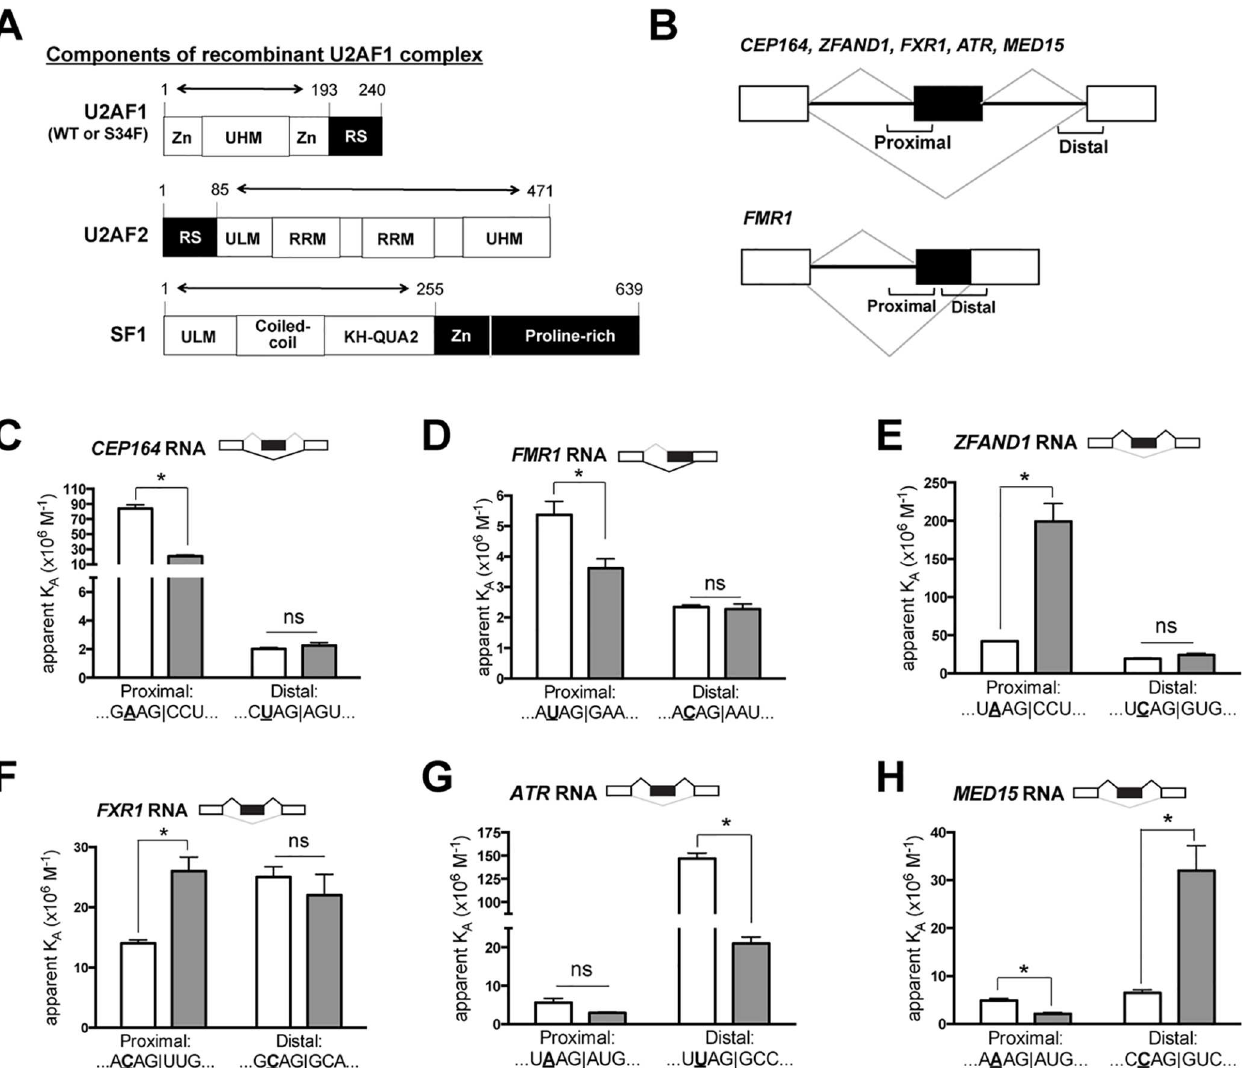
Fig 5. Differential binding of mutant and wild-type U2AF1 complexes to RNA oligonucleotides explains most S34F-associated alterations in RNA splicing. (A) . Cartoons illustrate components of recombinant U2AF1 complexes used in the bindingassay. Full-length proteins are shown but only partial sequences(denoted by bi-directional arrows) were used to make recombinant protein complexes. KH-QUA2, K-Homology Quaking motif; RRM, RNA recognition motif domain; RS, arginine/serine-rich domain; UHM, U2AF homology motif; ULM, U2AF ligand motif; ZnF, zinc finger domain. (B) . Scheme of alternativesplicing patterns for cassette exons (top diagram) and 5’ extended exons from competing 3 0 splice site selection(bottom). The brackets indicate the positionsof RNA oligonucleotides used for the bindingassays. Exons are shown as boxes: white boxes indicate invariant exonic sequences and black boxes denote sequencesthat are incorporated into mRNA (exonic) only when the proximal 3 0 splice sites are used. Introns are shown as solid lines. The grey lines represent possiblesplices. The names of characterized genes that conform to the patterns shown in the upper and lower cartoons are indicated. (C—H) . Mutant and wild-type U2AF1 complexes have different affinities (K A ’s) for relevant 3 0 splice site oligonucleotides. To accomplish the bindingassays, the wild-type or mutant U2AF1 protein complexes were titrated into 5’ fluorescein-tagged RNA oligonucleotides over a range of concentrations as describedin the Supplemental Materials and Methods. RNA sequencesfrom -4 to +3 relative to the 3 0 splice sites (vertical lines) in proximal and distal positions are shown. The nucleotideat the -3 position is boldedand underlined. Empty bars, K A for WT U2AF1 complex; grey bar, K A for mutant U2AF1 complex. For ease of comparison between the affinity bindingresults with S34F-associated splicing,S34F-promoted splices, as determinedfrom RNA-seq data, are shown on top of each bar graph in black lines. The fitted bindingcurves, full oligonucleotide sequences, and apparent equilibrium dissociationconstants are shown in S12 Fig. The relative changes in affinity and use of proximal versus distal splice sites are summarized in S3 Table. The asterisk represents a statistically significant changeby unpairedt-tests with Welch’s correction. ns, not statistically